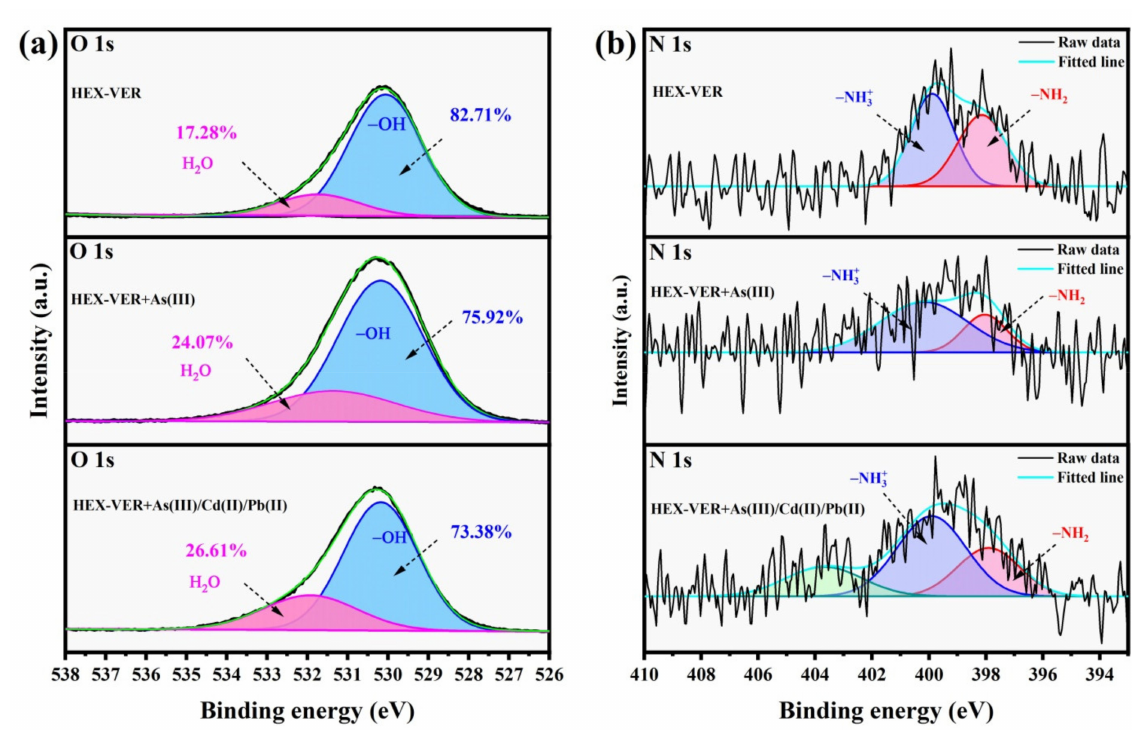
Figure 8. High-resolution spectra of O 1 s ( a ); and N 1 s ( b ) for before and after adsorption of As(III) and As(III)+Cd(II)/Pb(II) onto